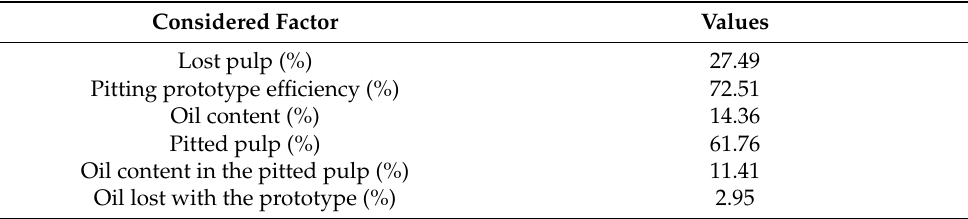
Table 4. Pitting prototype